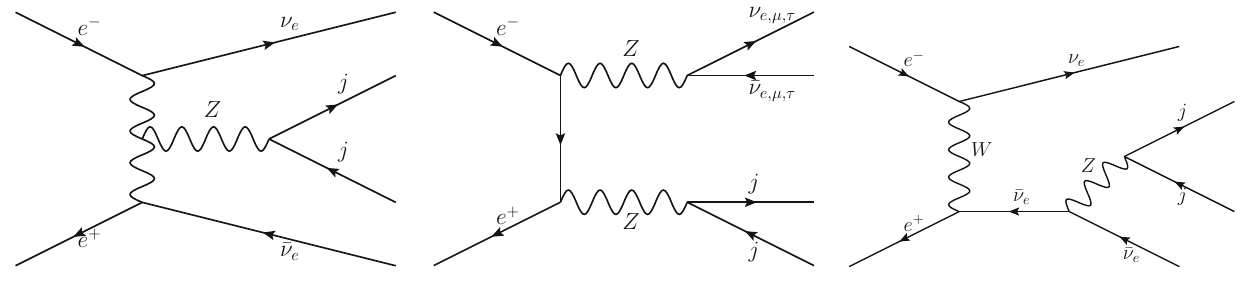
Fig. 1 Dominant background processes for hadronic mode of our signal